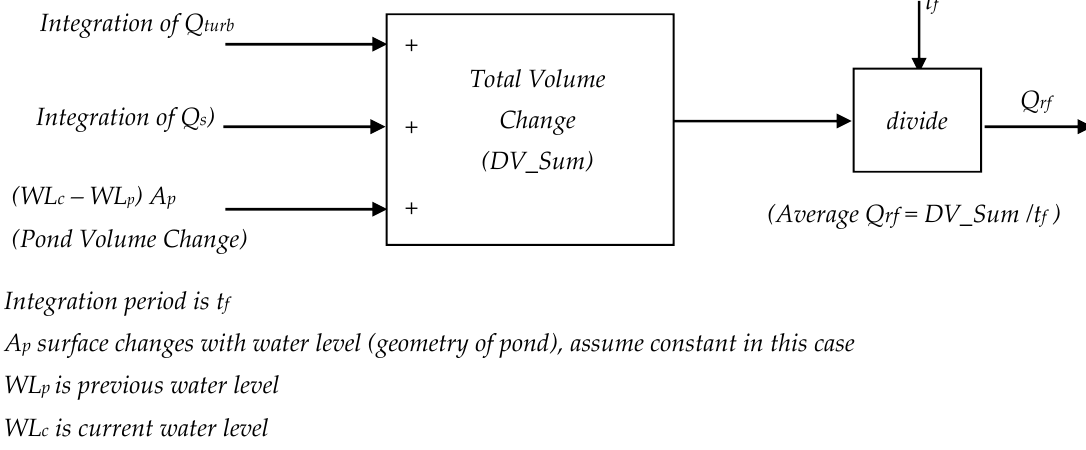
Figure 4. River flow as summation of turbine discharge, spillage and pond volume rate.